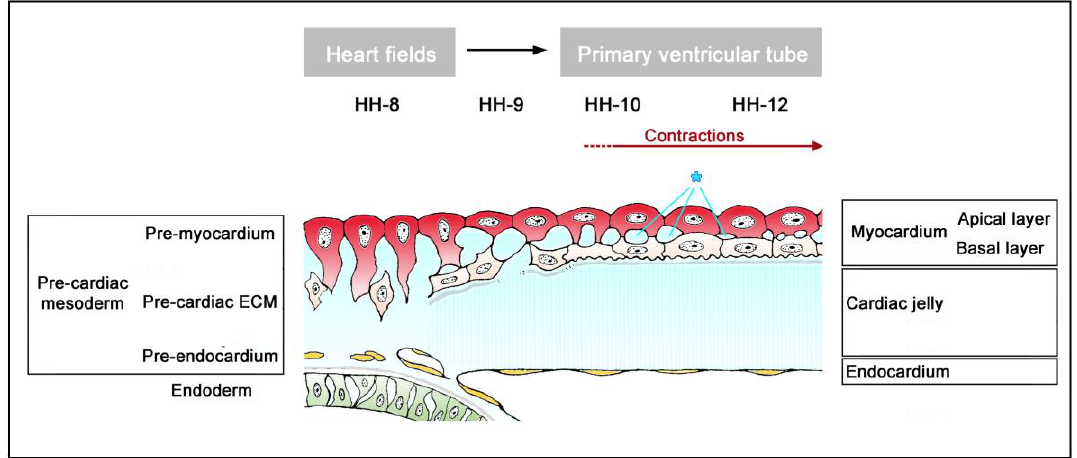
Figure 3. This schematic drawing illustrates the establishment of the primary wall architecture and initiation of myocardial contractions in the tubular hearts of higher vertebrate embryos as seen in the chick (based on data from Manasek [37] and Sakai et al. [39]). Developmental stages according to Hamburger and Hamilton [36] are indicated as HH-8, etc. The components of the primary heart wall derive from the pre-cardiac mesoderms. These parts of the lateral plate mesoderm harbor: (1) A coelomic epithelium formed by myocardial progenitors (pre-myocardium); (2) endocardial progenitors (pre-endocardium), which are found in close association with the endoderm; and (3) a gelatinous ECM (pre-cardiac ECM), which connects the pre-myocardium and pre-endocardium with each other, and with the endoderm. Note that the pre-cardiac mesoderms do not possess an anatomically well-demarcated myoendocardial space. The appearance of such a space depends on myocardial differentiation and the formation of endocardium-lined tubes. During myocardial differentiation, the discontinuous basal layer of the pre-myocardium becomes transformed into a continuous cell sheet bordered by a basal lamina. Consequently, the developing myocardium becomes an anatomically well-demarcated two-layered epithelium and the pre-cardiac ECM becomes split into two compartments: (1) An intramyocardial ECM (marked by asterisks) and (2) a cell-free myoendocardial ECM (CJ).